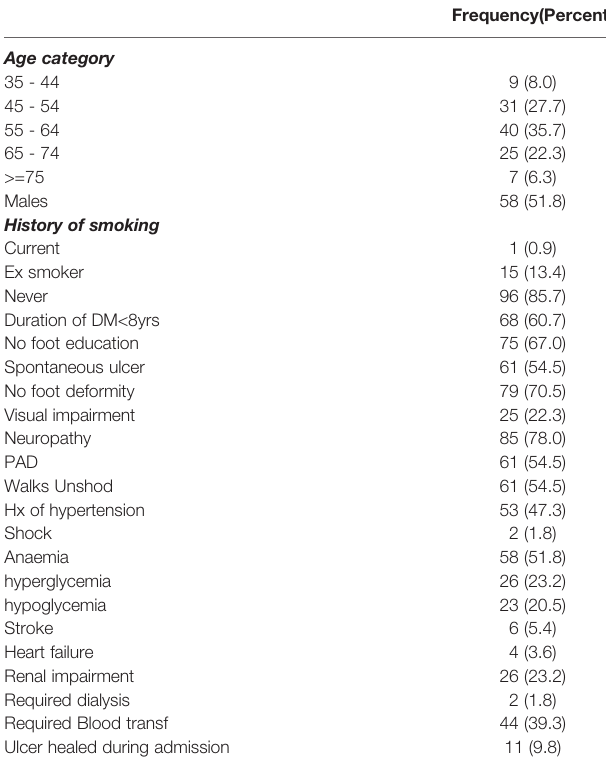
TABLE 1 | Demographics, Ulcer characteristics and clinical